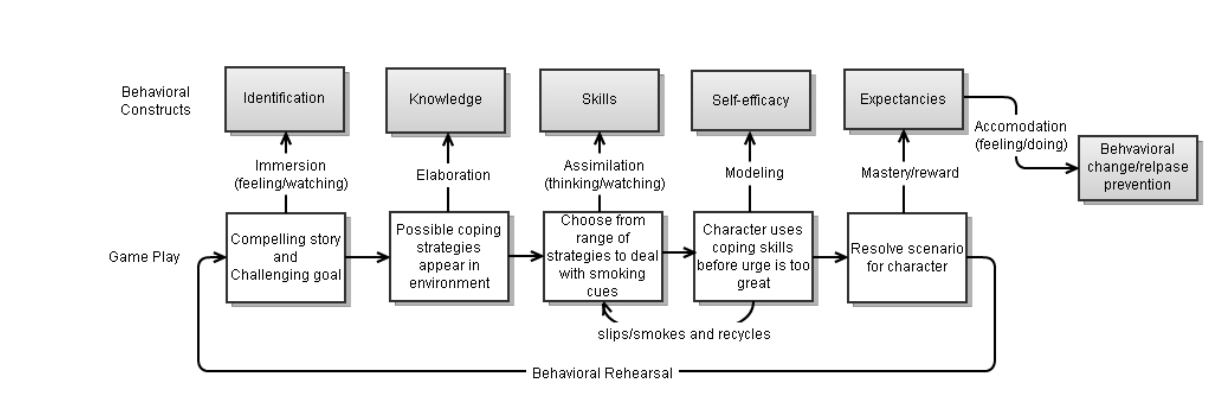
Figure 1. Integration of game mechanics with behavior change